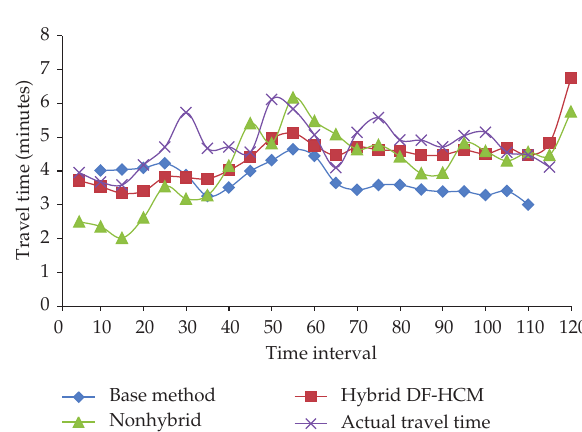
Figure 3: Sample travel time results using field data.